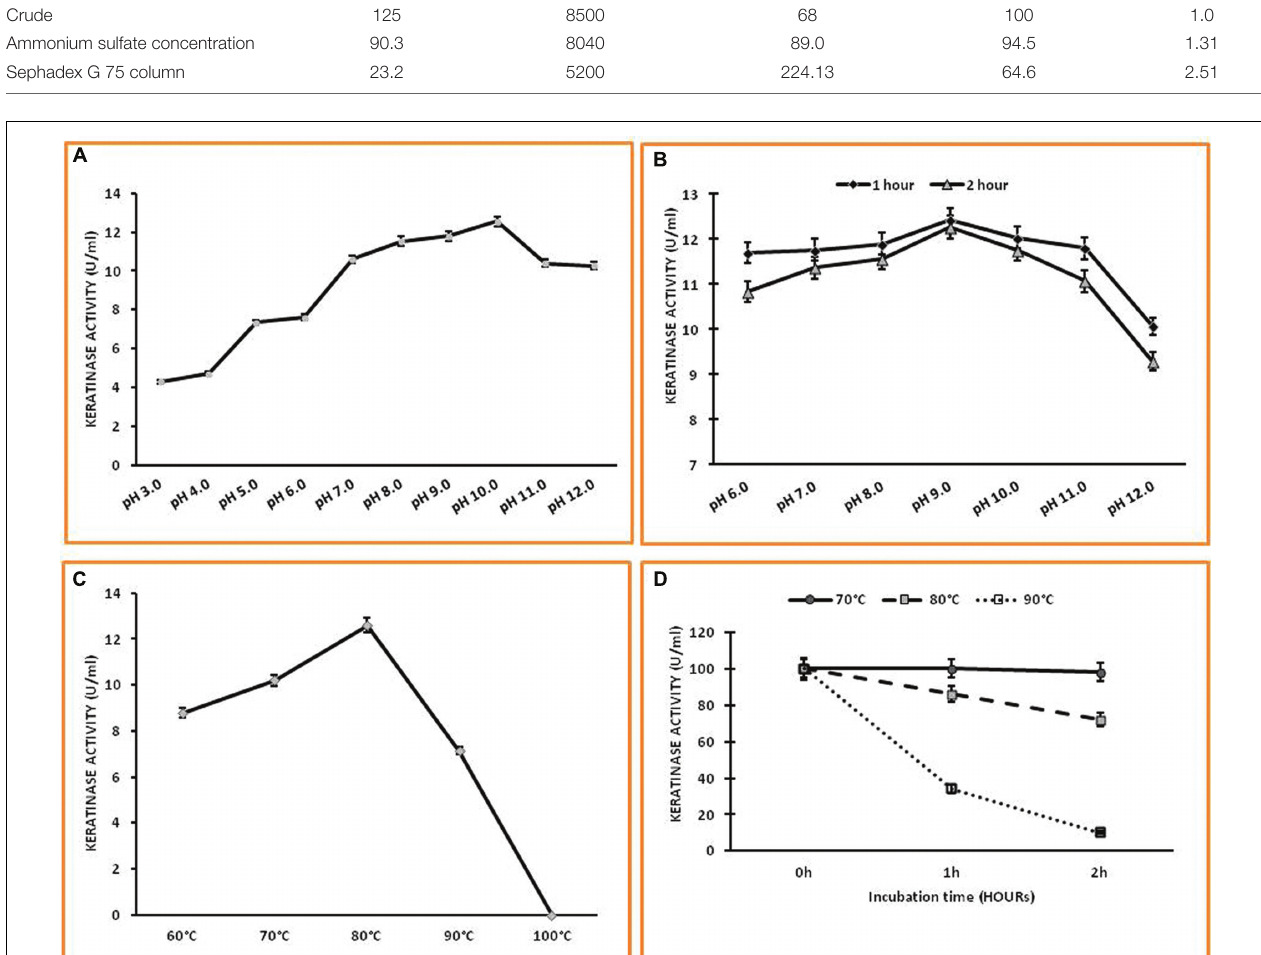
FIGURE 5 | Characterization of keratinase from Thermoactinomyces sp. RM4. (A,B) Effect of pH on the activity and the stability of Keratinase enzyme; (C,D) Effect of temperature on keratinase activity and